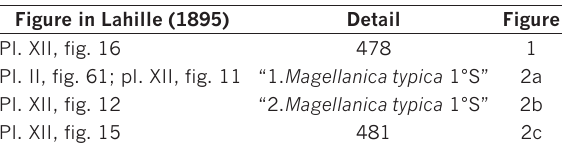
Table 1. Voluta ambigua typica , specimens figured by Lahille (1895) with the detail of the inscriptions on their shells and figures here.